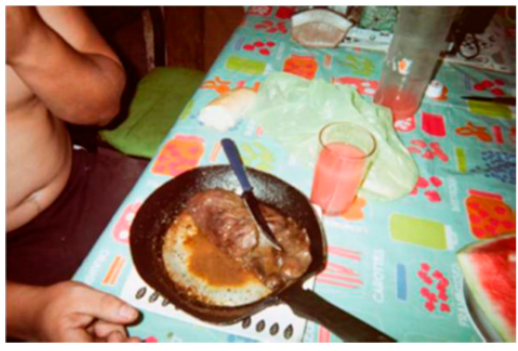
Figure 3. A piece of fried meat.